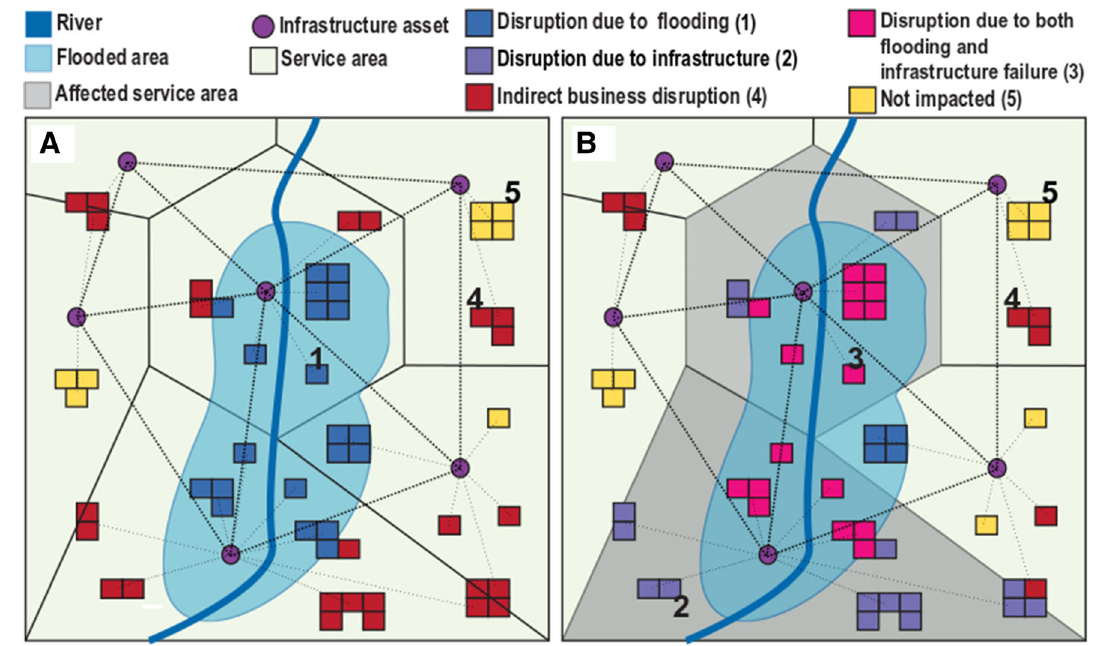
Fig. 1 Hypothetical cartogram depicting flood hazard impact areas and business disruption. The figure illustrates the two loss estimation branches and the difference in affected business activities. Panel A